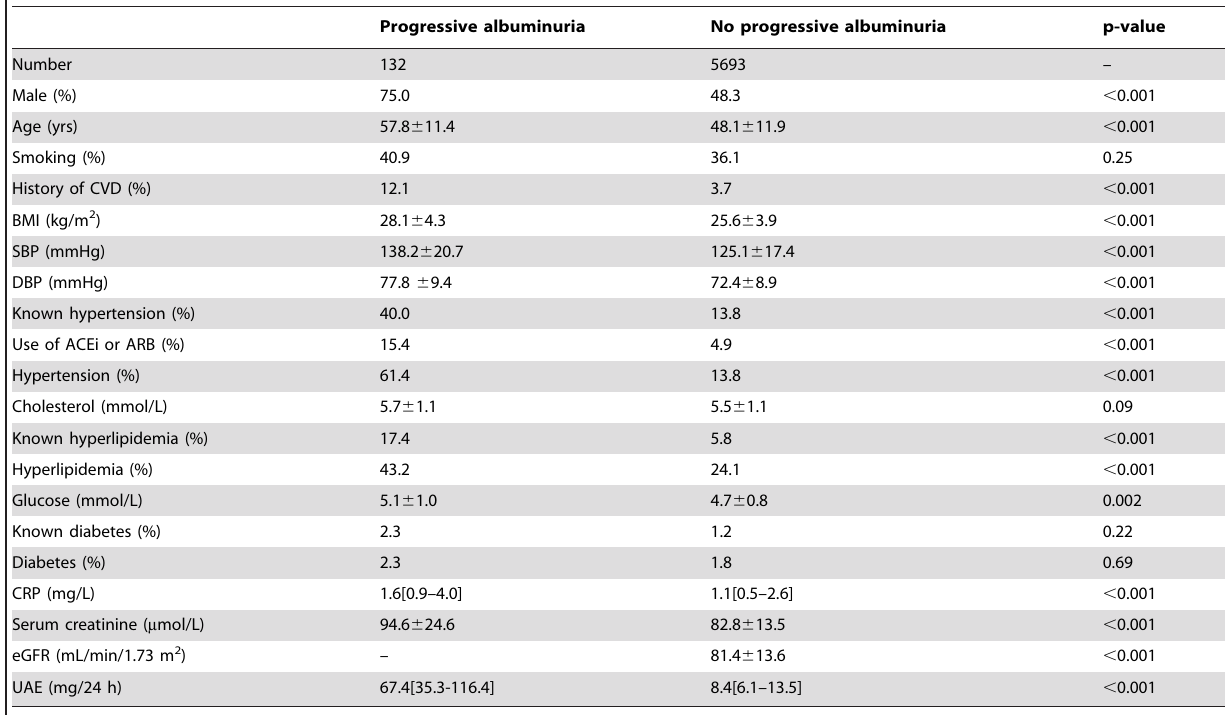
Table 1. Baseline